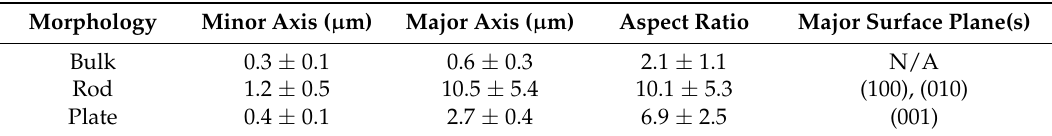
Figure 1. SEM image of [Zn 2 (NDC) 2 (DABCO)] ( a ) unmodulated resulting in bulk morphology ( b ) 1.6 M acetic acid as a modulator resulting in rod morphology and ( c ) 1.6 M pyridine as a modulator resulting in plate morphology. Scale bars are 5 µm. Table 1. Minor axis, major axis, and aspect ratio measurements for different morphologies of [Zn 2 (NDC) 2 (DABCO)] n .